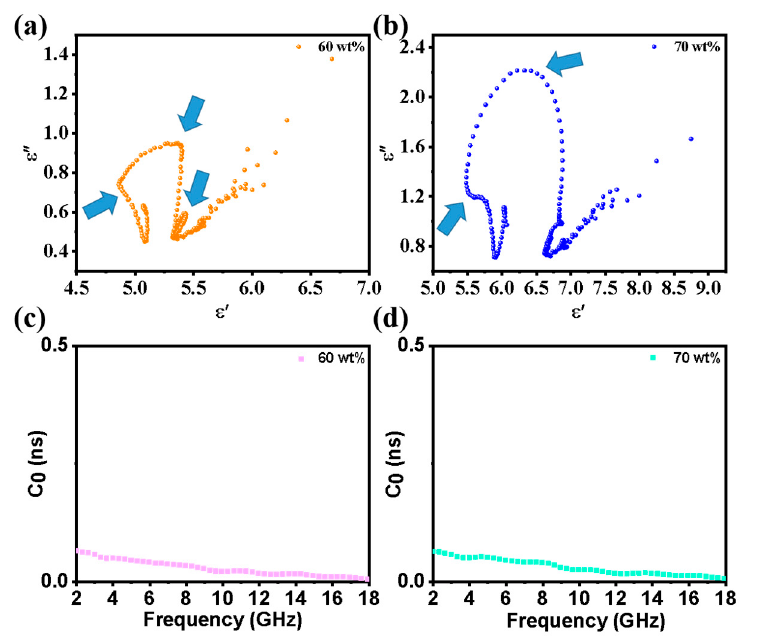
Figure 6. Cole–Cole curve of ( a ) 60 wt%, ( b ) 70 wt% FeNi 3 alloy mass ratio sample, C 0 curves of ( c ) 60 wt%, ( d ) 70 wt% FeNi 3 alloy filling ratios sample.